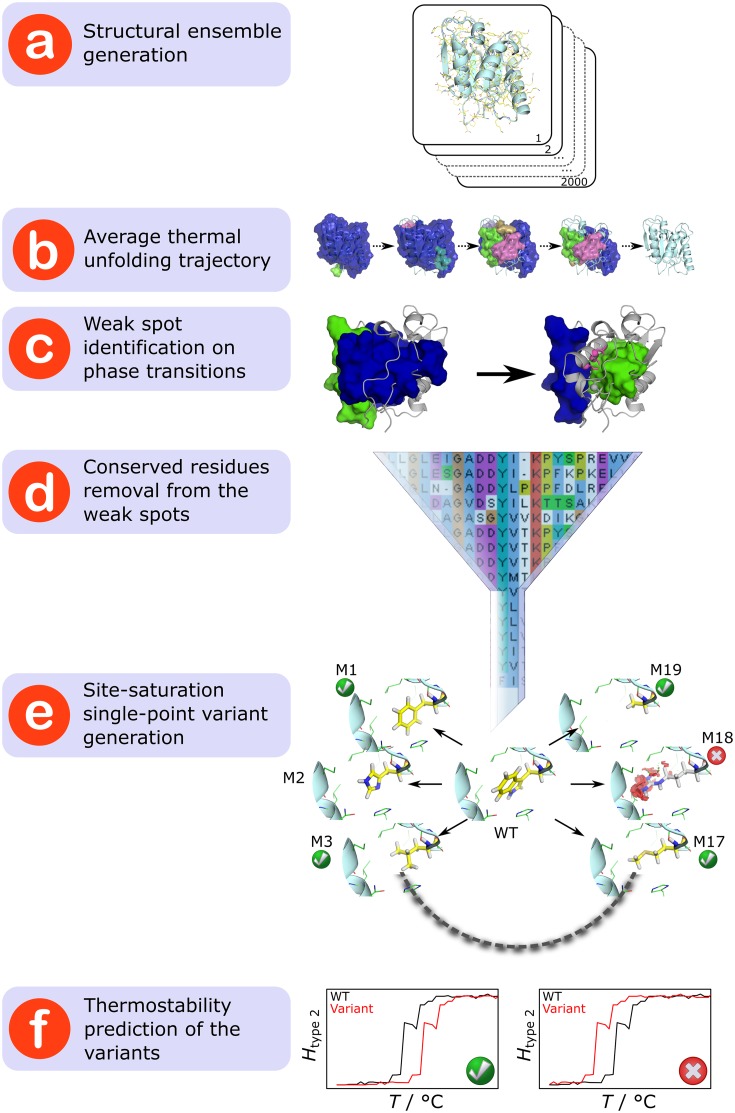
Strategy to rationally predict mutations that increase structural rigidity and thermostability.(a) A structural ensemble of the respective protein is generated by MD simulations. (b) The average thermal unfolding trajectory depicting a decomposition into rigid clusters (in the order of decreasing size colored in blue, green, magenta, cyan, orange, and violet) for each step of the unfolding simulation is created by subjecting the structural ensemble to CNA. (c) For every major transition during the thermal unfolding, weak spot residues (depicted as a sphere for the Cα atom and sticks for the side-chain) are identified. (d) Weak spot residues that are highly conserved across the protein family (≥ 80% identity) are removed from the weak spot list. (e) For the rest, structures of site-saturation single-point variants (termed M1–M19) are generated. Mutations that lead to energetically unfavorable structures (indicated by red discs around the mutated residue in the case of M18) are discarded. (f) For each variant, the phase transition temperature Tp is computed using CNA; a higher Tp value than that of the WT protein indicates a thermostabilizing mutation.